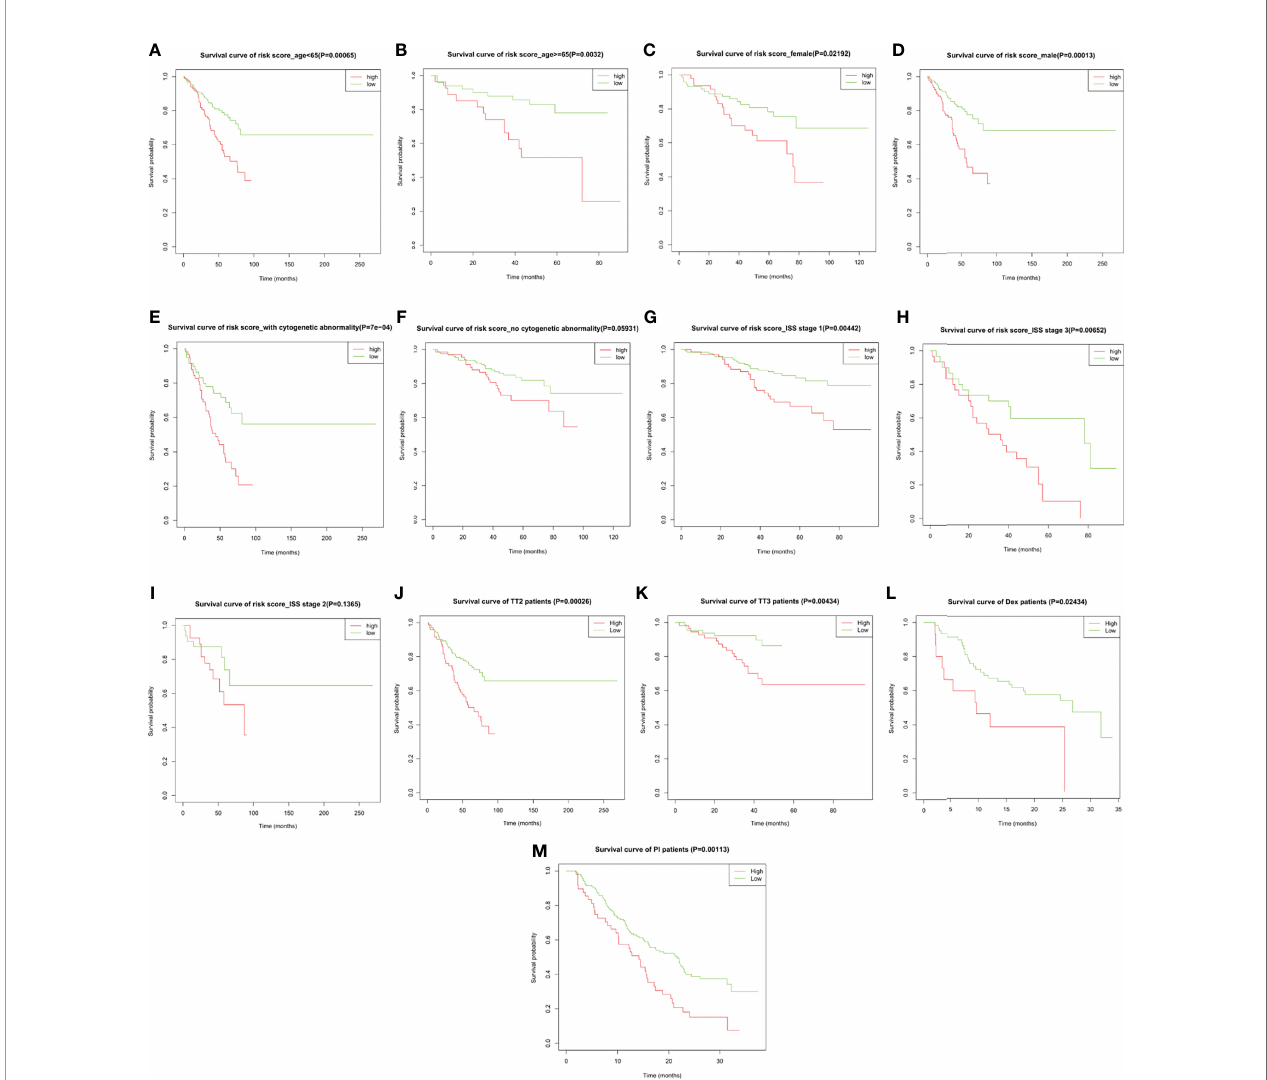
FIGURE 5 | The overall survival probability in high- and low-risk MM patients grouped by clinicopathological features and therapeutic regimens. Kaplan – Meier survival analysis of MM patients from GSE24080 strati fi ed by (A, B) age ≤ 65 and >65, (C, D) female and male, (E, F) with and without cytogenetic abnormalities, (G – I) ISS stage I/II/III, and (J, K) total therapy 2 (TT2) and TT3 regimen. Kaplan – Meier survival analysis of MM patients from GSE9782 strati fi ed by (L, M) dexamethasone (DEX) treatment and proteasome inhibitor (PI)